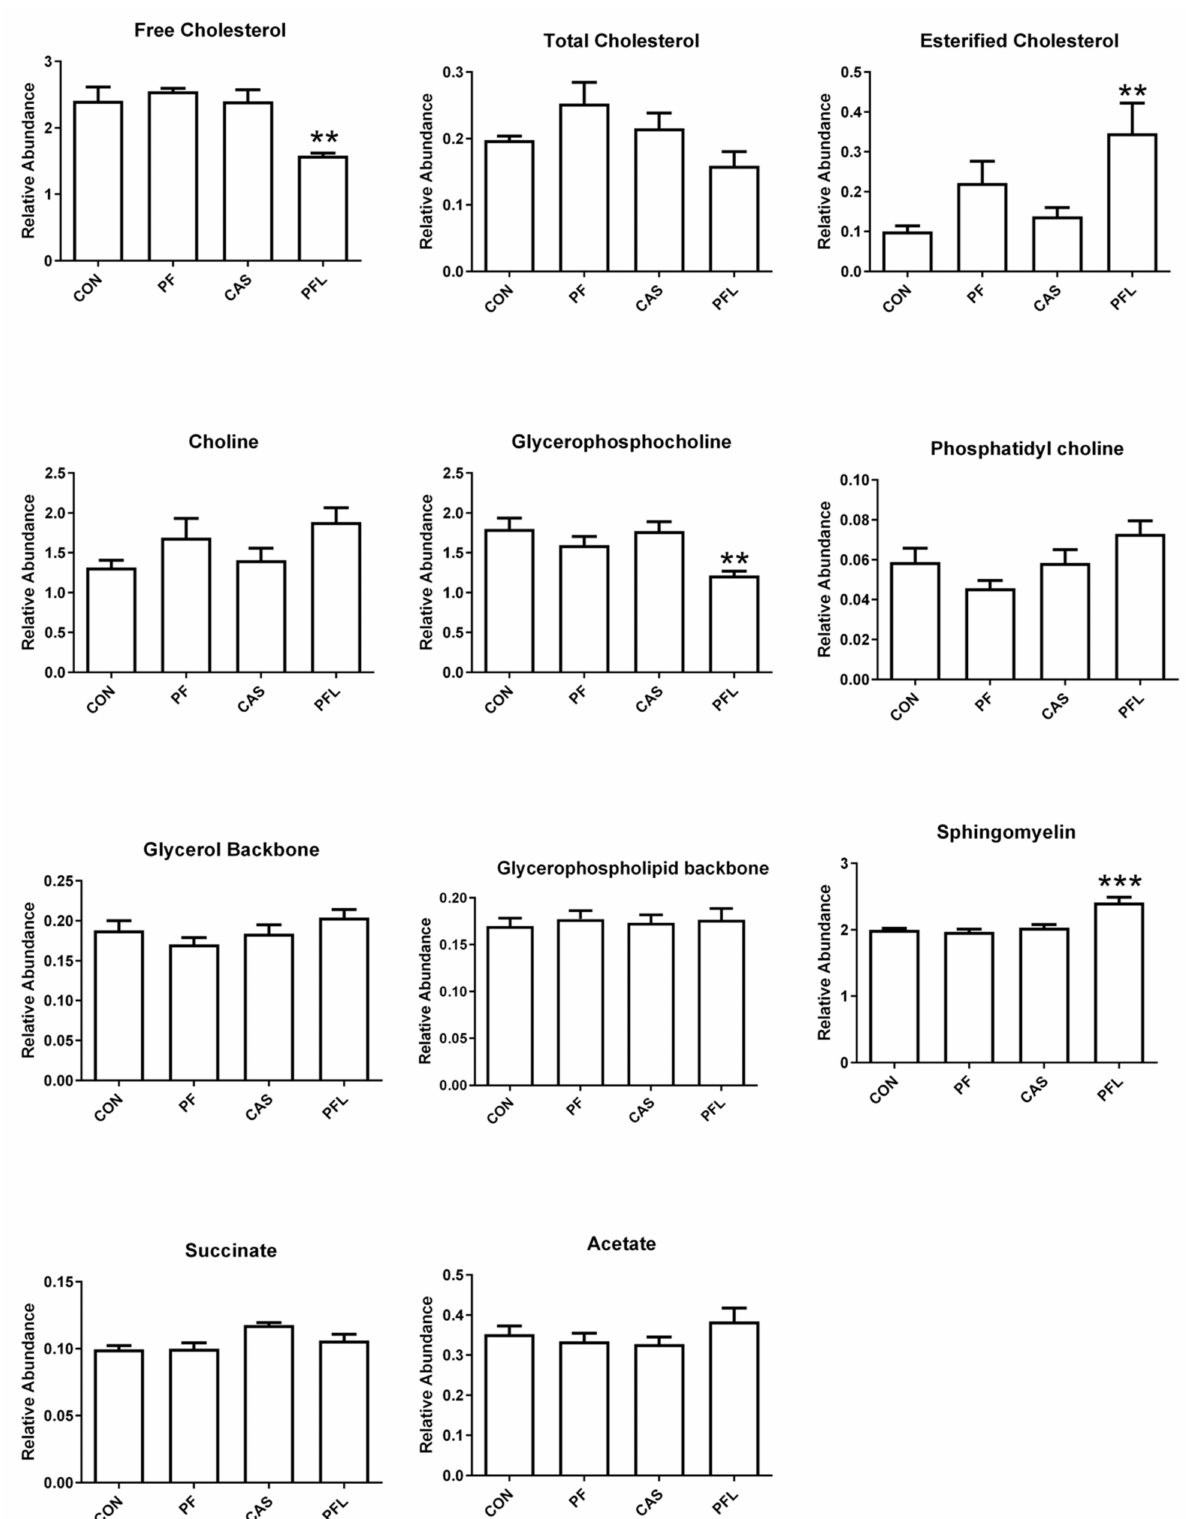
Figure 8. Relative quantification of the major differentiating metabolites in the liver. based on the mean peak area of the related NMR signals. CON = Basal diet without RBF, PF = Basal diet plus prilled fat, CAS = Basal diet plus calcium soap, PFL = Basal diet plus prilled fat with lecithin. Statistical icons: ** p < 0.01, and *** p <